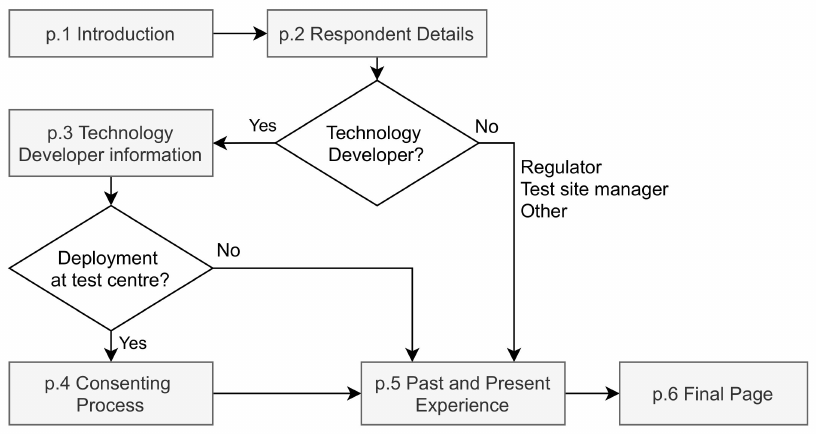
Figure 1. Survey